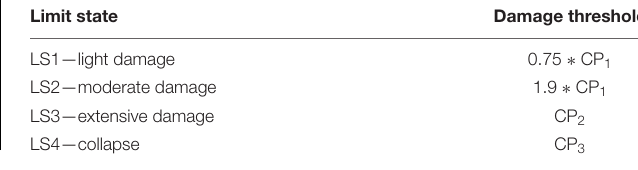
TABLE 3 | Damage thresholds associated with limit